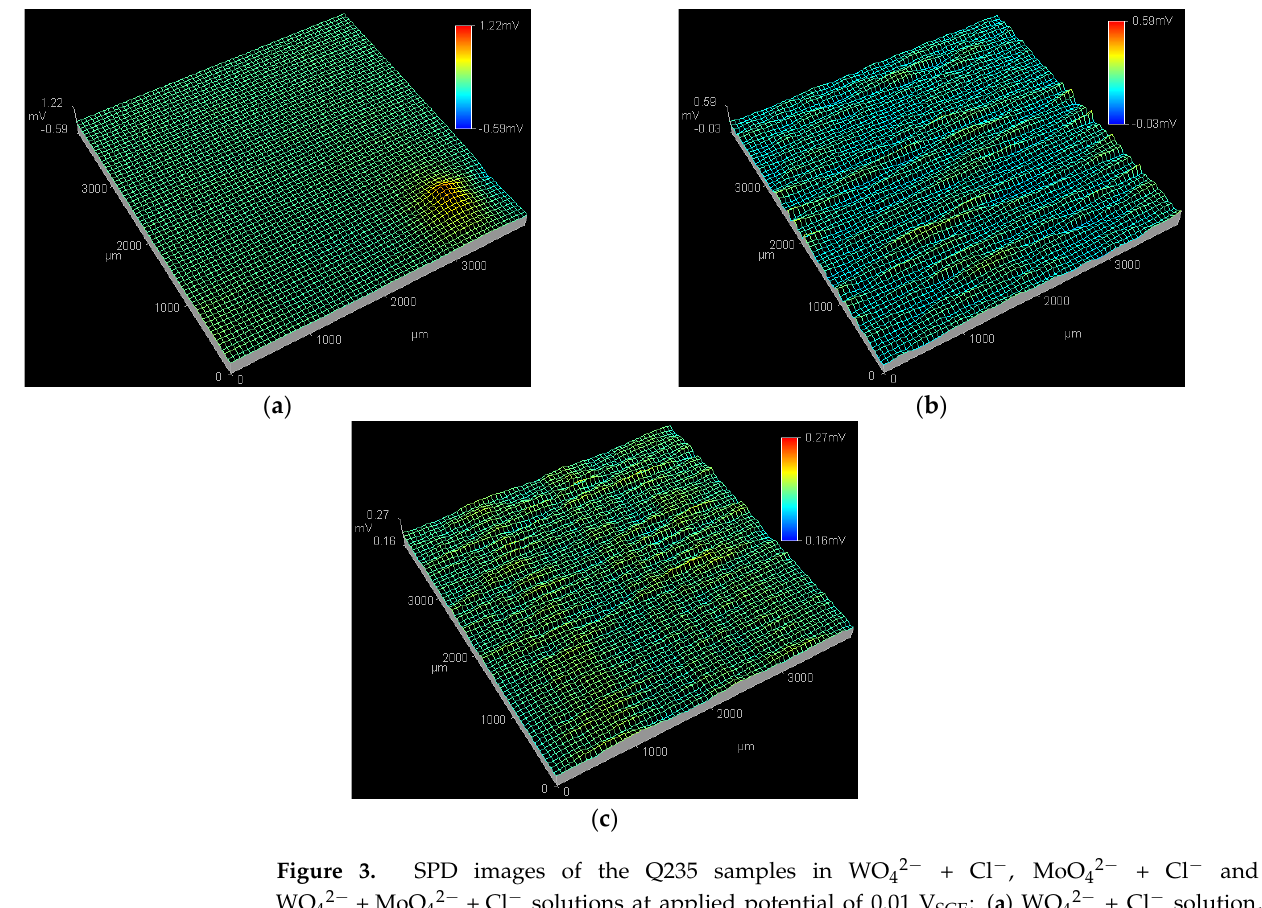
Figure 3. SPD images of the Q235 samples in WO 4 2− + Cl − , MoO 4 2− + Cl − and WO 4 2− + MoO 4 2− + Cl − SPD images of the Q235 samples in WO 42 − + Cl − , MoO 42 − + Cl − and solutions at applied potential of 0.01 V SCE : ( a ) WO 4 2− + Cl − solution, ( b ) MoO 4 2− + Cl − solution and ( c ) WO 42 − + MoO 42 − + Cl − solutions at applied potential of 0.01 V SCE : ( a ) WO 42 − + Cl − solution, WO 4 2− + MoO 4 2− + Cl − solution. ( b ) MoO 42 − + Cl − solution and ( c ) WO 42 − + MoO 42 − + Cl −